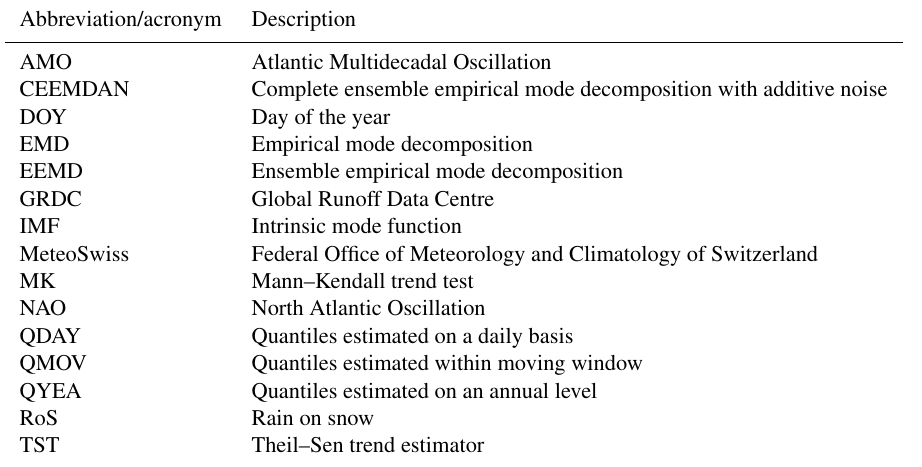
Table B1. Abbreviations and acronyms in alphabetical